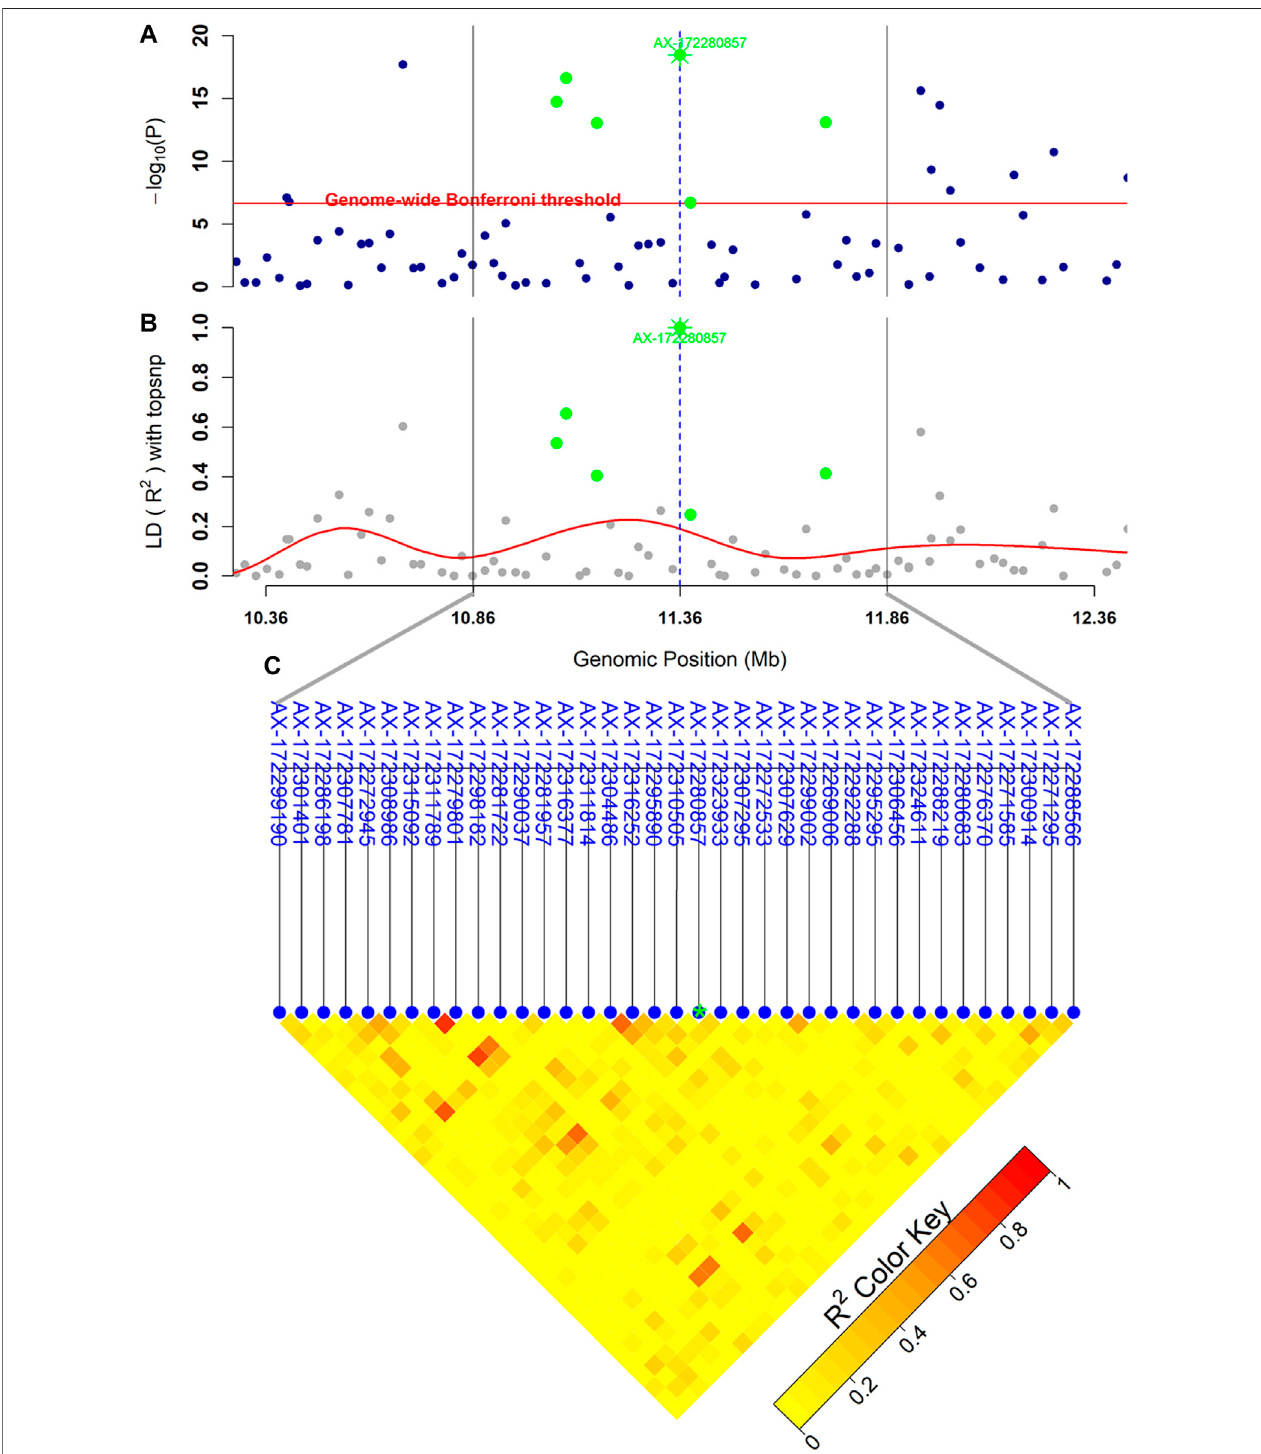
FIGURE3| High-resolutiondepictionoftheQTLregionatLG12withlinkagedisequilibriuminformation. (A) displaysthedistributionof − log 10 ( p ) intheQTLregion, thehorizontalred linerepresents thegenome-wide Bonferroni-correctedthreshold, (B) exhibitstheLDofSNPs withthehighest signi fi cantSNP,thesolidred lineshows the pattern ofLDdecay from thehighest signi fi cant SNP,and (C) shows theLD among theSNPs within1.0 Mb (10.86 – 11.86 Mb). The green dots denote the genome- wide signi fi cant SNPs, while the asterisk dot is the highest signi fi cant SNP of GWAS analysis. The dashed vertical blue line shows the position of the highest signi fi cant SNP, and the fainted vertical gray lines mark the 1.0 Mb region with ±500 Kb from the highest signi fi cant SNP.